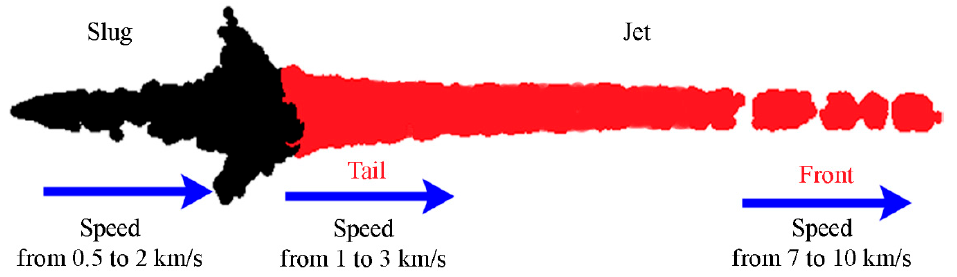
Figure 1. Speeds of the resulting individual components of the collapsing liner.